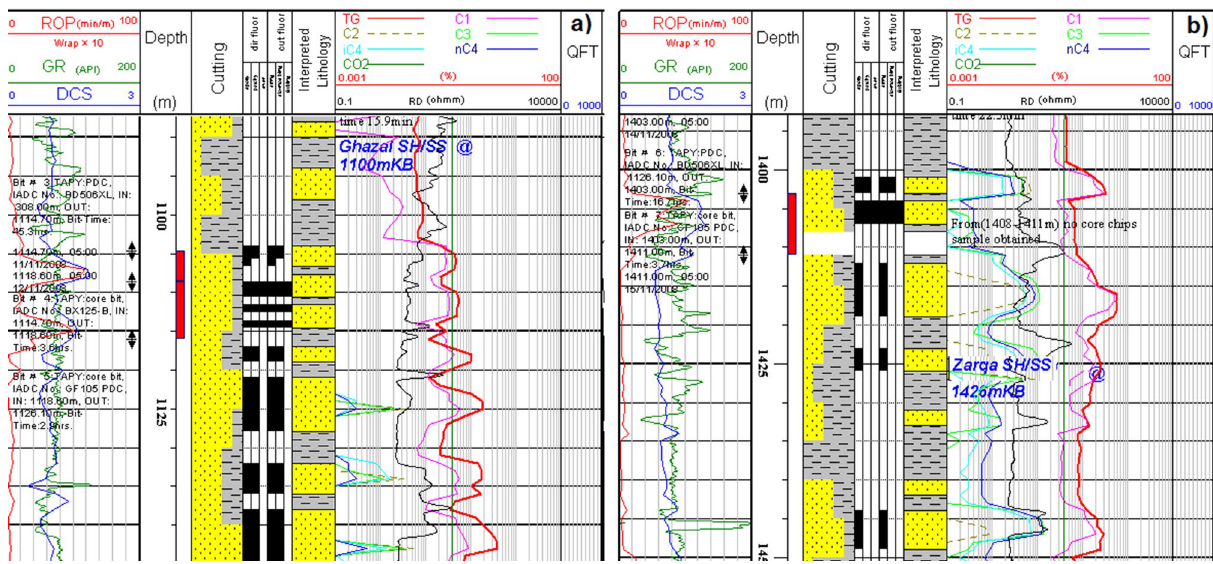
Figure 6. Well log response of Zarga ( a ) and Ghazal ( b ) formations